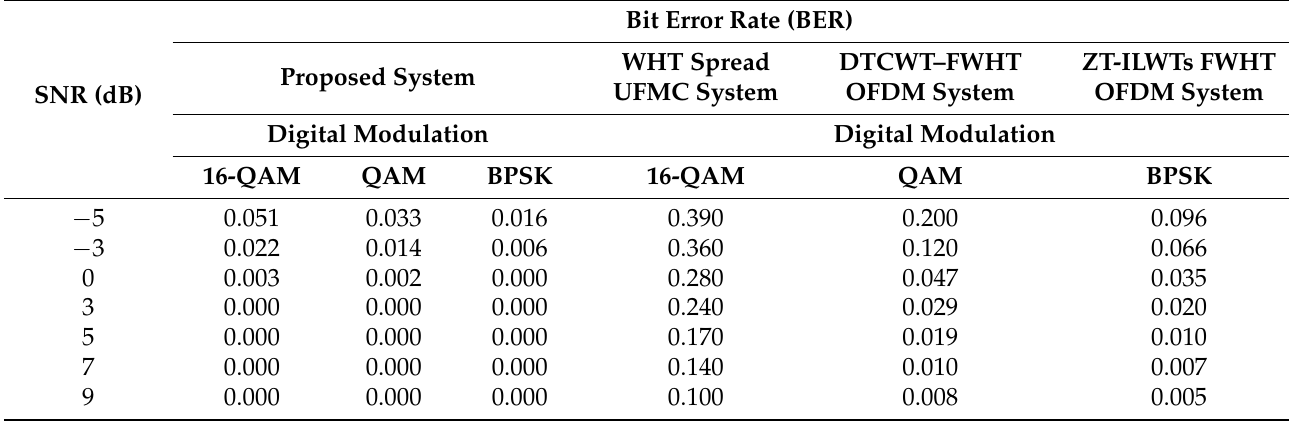
Table 5. Estimated BER Values in Comparative